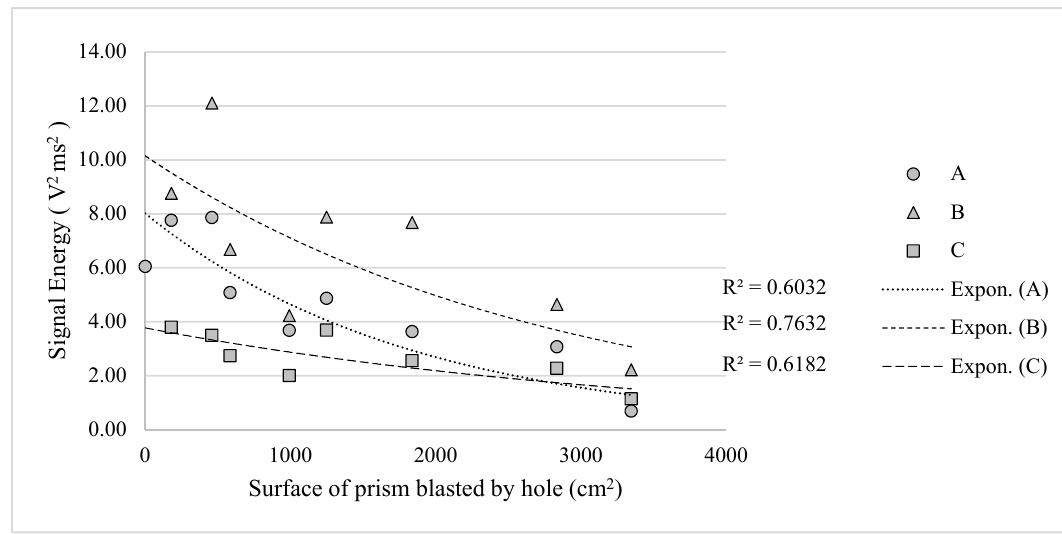
Figure 9. Considering only the peak-to-peak voltage, sensor C showed a shock behavior that was drastically different from the other two.